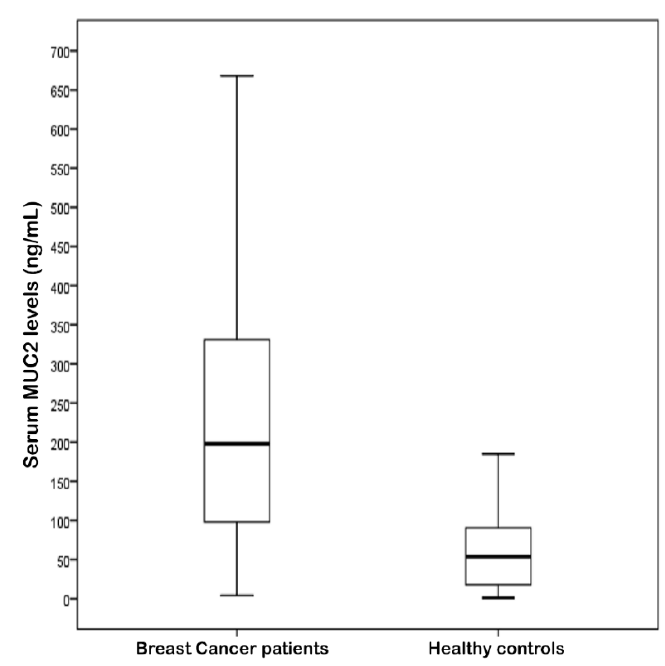
Figure 1. The values of serum MUC 2 levels in patients with breast cancer and healthy controls ( p <0.001).